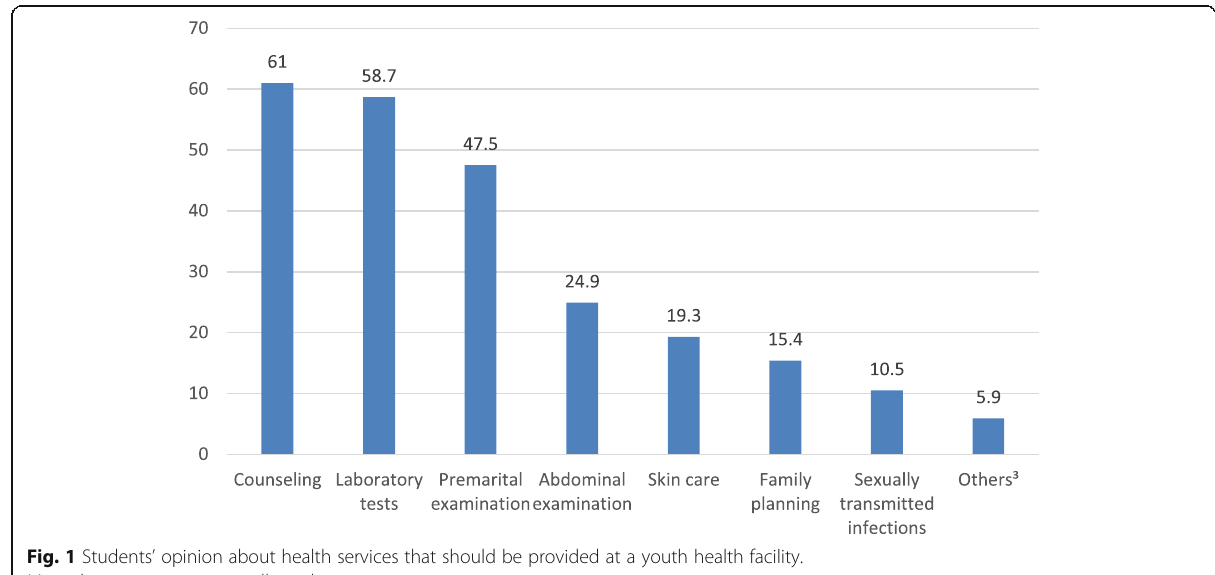
Fig. 1 Students ’ opinion about health services that should be provided at a youth health facility. More than one answer was allowed. ¤ Others includes psychological, nutritional care by dietitians, and regular follow up